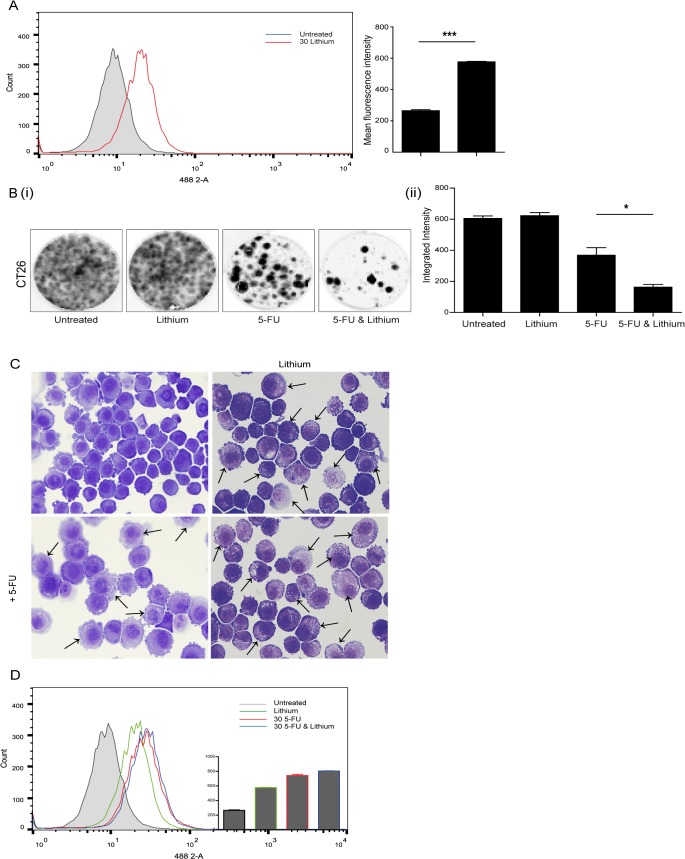
Assessment of the effect of combining autophagy inducers on chemosensitivity in CT26 murine colorectal cells.(A) The induction of autophagy in CT26 cells, following lithium treatment (30 mM) for 24 hours, was assessed with the Cyto-ID autophagy detection kit. (B) Viable cells following treatment with lithium alone or in combination with 5-fluorouracil (5-FU) (20 μM) for 24 hours were counted and equal numbers reseeded in triplicate, in the absence of drug. (i) Cells were allowed to grow for 14 days, then were fixed and stained and colonies quantified using the Odyssey Infrared Imaging System (Li-COR). (ii) Data is presented graphically as the mean +/- SEM of three independent experiments. Asterisks indicate a significant difference in the number of colonies formed in combination treated cells compared to single agent treated cells (* p < 0.05) (unpaired t-test). (C) Morphological features of CT26 cells were examined following treatment for 24 hours. Panels to the right show the morphology induced in response to lithium alone (upper) and in combination with 5-FU (lower). Lower left panel shows morphology in cells treated with 5-FU alone. Arrows indicate the accumulation of vesicles in lithium, 5-FU and combination treated cells (Magnification 40x). (D) Cells were treated with either lithium (30 mM), 5-FU (20 μM) or a combination of both for 24 hours and autophagy levels assessed with the Cyto-ID autophagy detection kit. Representative image of FACS analysis with insert showing corresponding mean fluorescence intensity (n = 3).